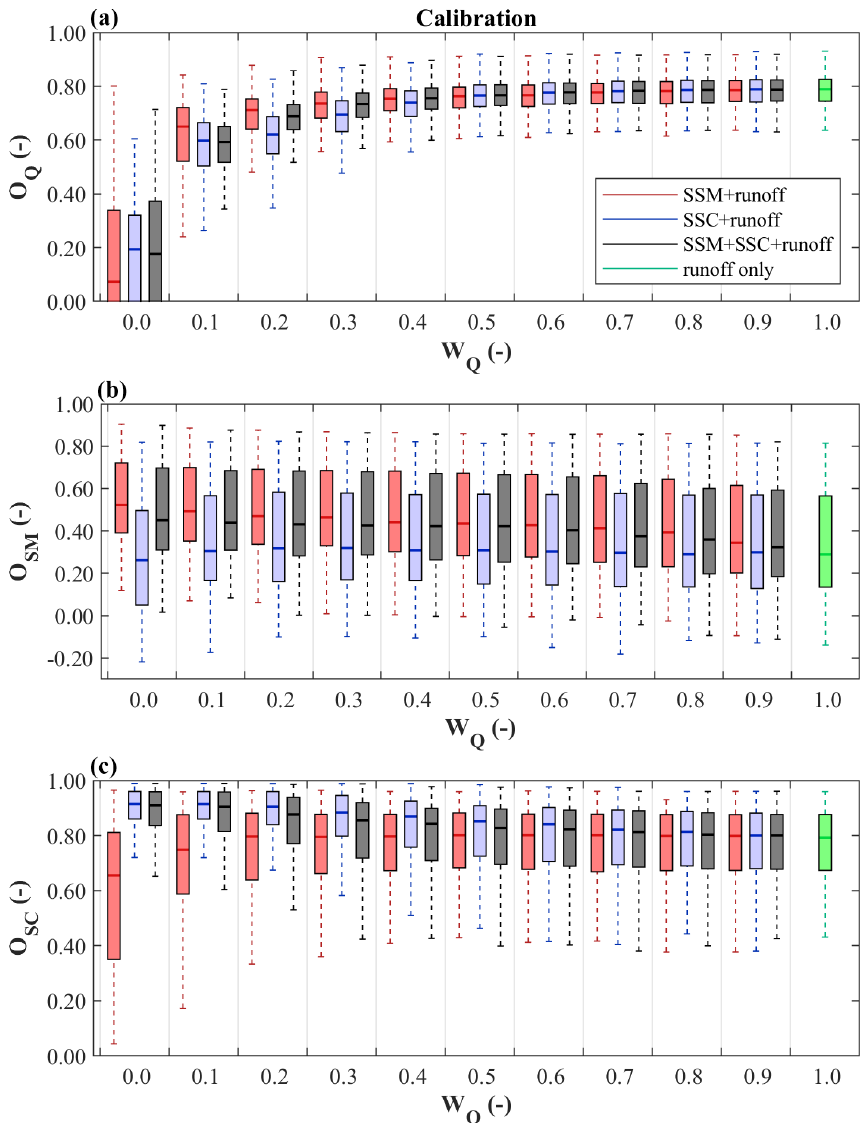
Figure 3. Hydrologic model performance for the following three multiple objective calibration variants: calibration to satellite soil moisture and runoff (red boxes), calibration to satellite snow cover and runoff (blue boxes), and calibration to satellite soil moisture, snow cover, and runoff (gray boxes). Panels (a) , (b) , and (c) show runoff (Eq. 2), soil moisture (Eq. 5), and snow cover (Eq. 6) model efficiency for different weights of the runoff objective w Q in the calibration period 2000–2010, respectively. w Q = 1 represents calibration to runoff only. Boxes represent the values from the different catchments, and the size of the boxes represents the spatial variability across the 213